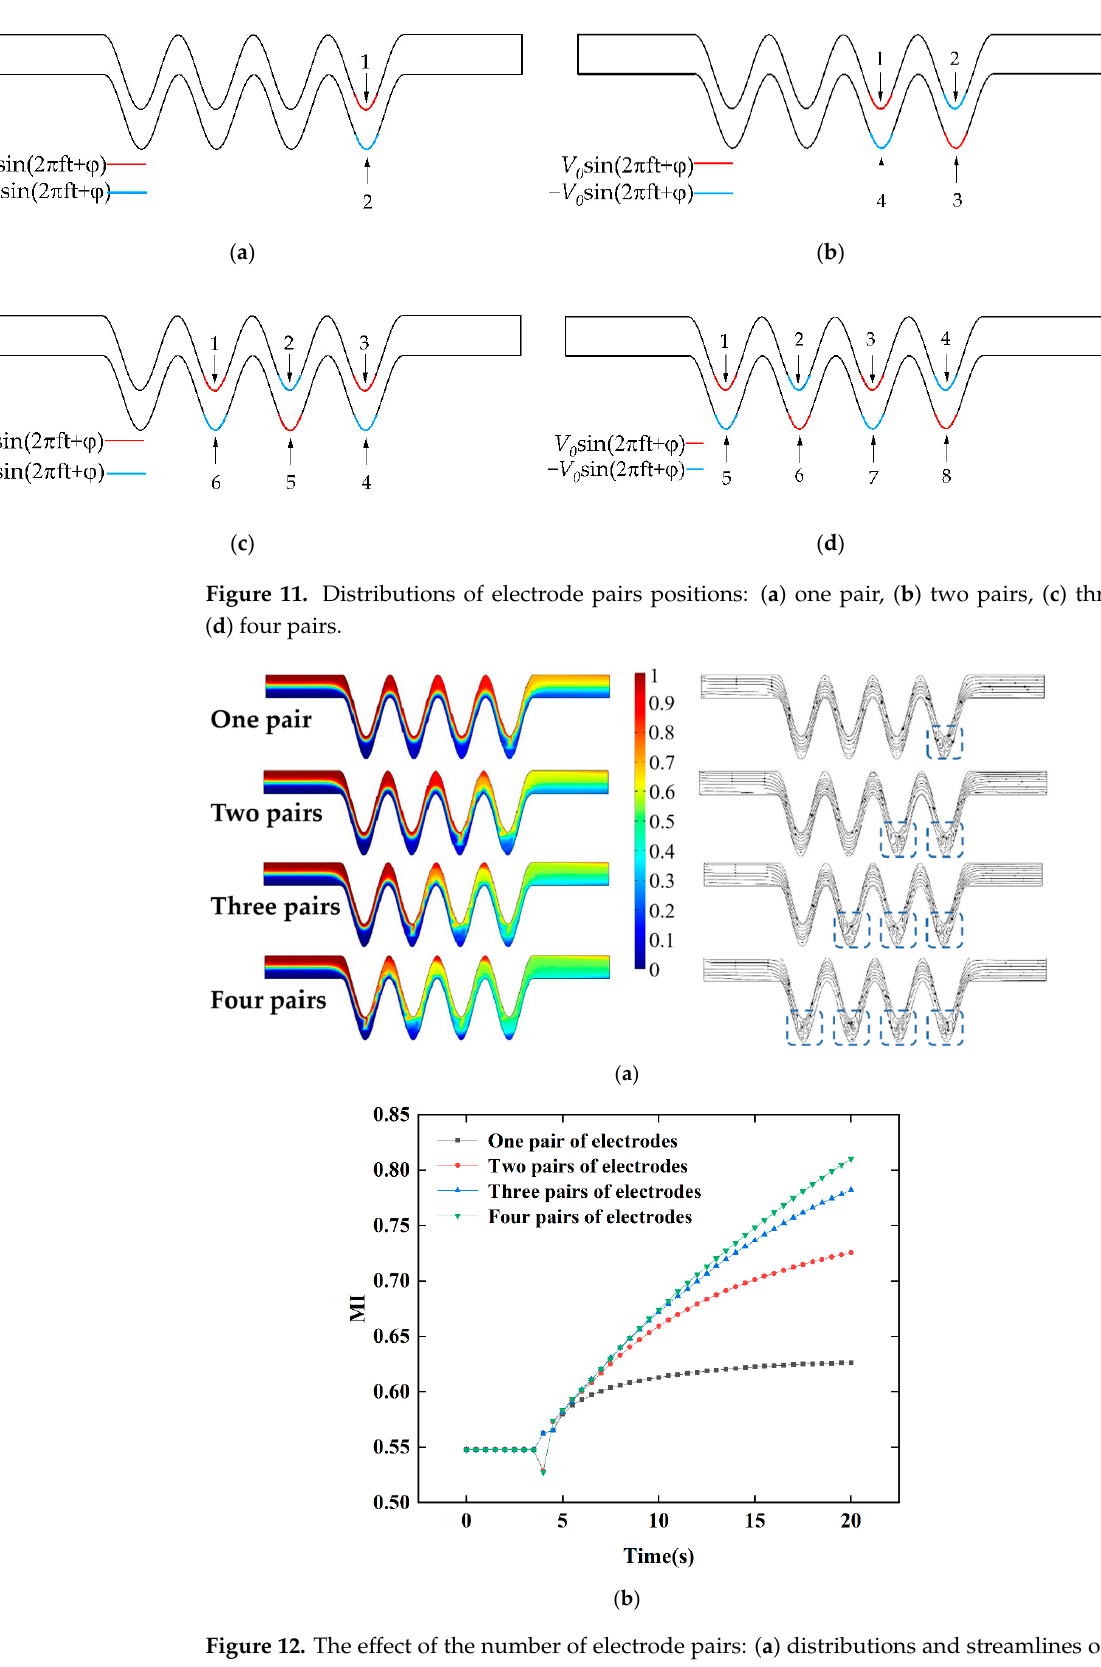
Figure 12. The effect of the number of electrode pairs: ( a ) distributions and streamlines of concen- tration surface along the micromixer for different electrode pairs, ( b ) the mixing index at the outlet for different electrode pairs within 0–20 s when phase shift of pi/4, U 0 = 0.1 mm/s, V 0 = 2 V, and f = 5 Hz .